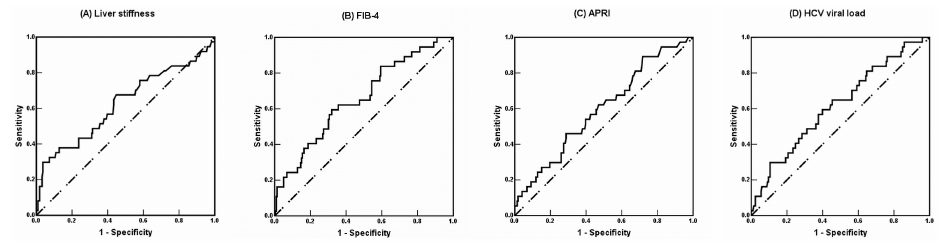
Fig 2. Receiver operating characteristic (ROC) curves using baseline liver stiffness (LS), fibrosis-4 (FIB-4) index, and the aspartate aminotransferase-to-platelet ratio index (APRI), and hepatitis C viral (HCV) load to dichotomize sustained virologic response (SVR) (no versus yes). According to the ROC analysis, the areas under curves were 0.624 (95% confidence interval, 0.514–0.733), 0.655 (0.560–0.751), 0.594 (0.496–0.692), and 0.618 (0.520– 0.716) for baseline LS (A), the FIB-4 index (B), APRI (C), and HCV viral load (D), respectively, to dichotomize SVR (no versus yes). The comparison of the AUCs was not significant between the FIB-4 index and LS ( P = 0.4231), between the APRI and LS ( P = 0.4621), or between the HCV viral load and LS ( P = 0.8104).